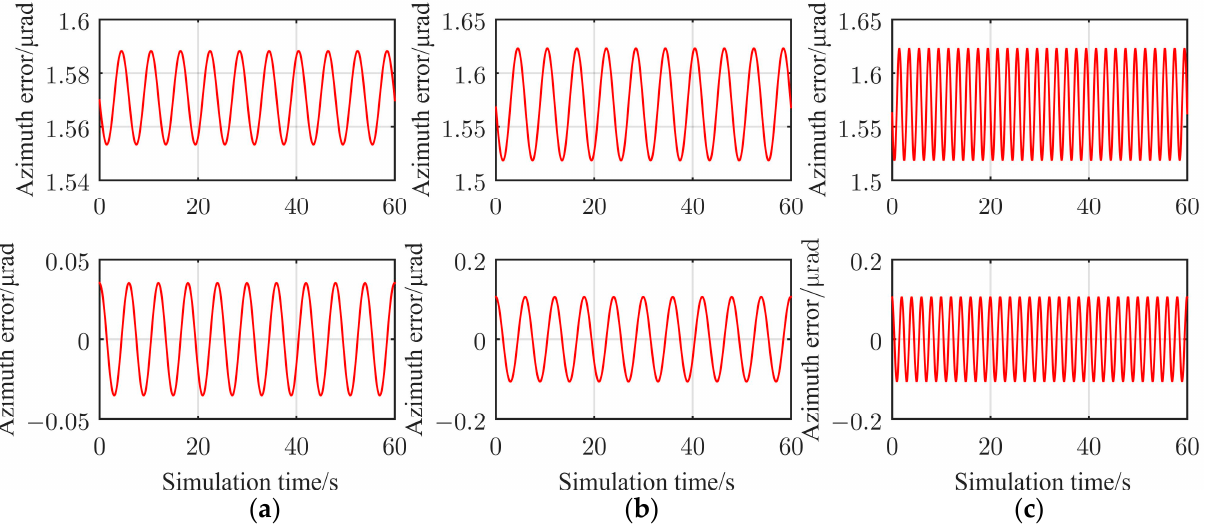
Figure 12. The error curve of the calculation of the indirect numerical calculation method in the reflector coordinate system O 43 X 43 Y 43 Z 43 . ( a ) a = 1 ◦ , ω = 60 ◦ /s; ( b ) a = 3 ◦ , ω = 60 ◦ /s; ( c ) a = 1 ◦ , ω = 180 ◦ /s.